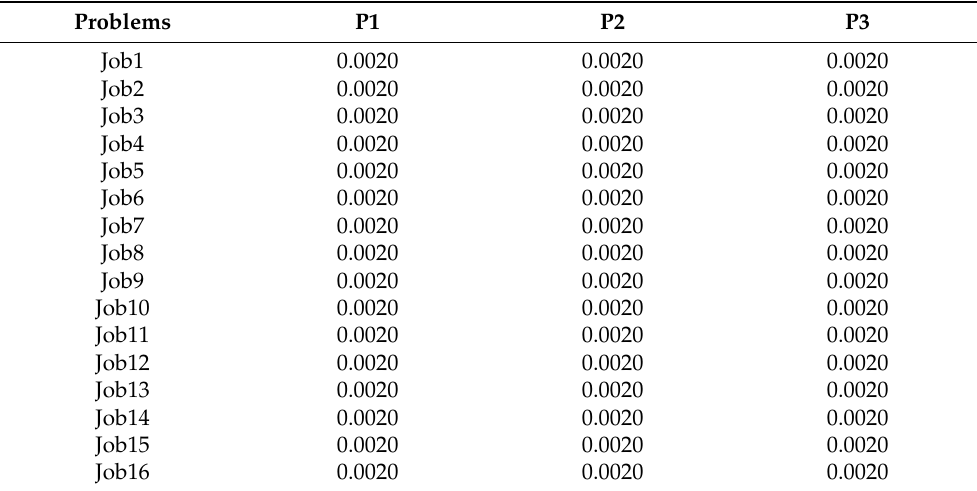
Table 9. The p -value of the Wilcoxon signed-rank test of the C -metric between two algorithms. Problems